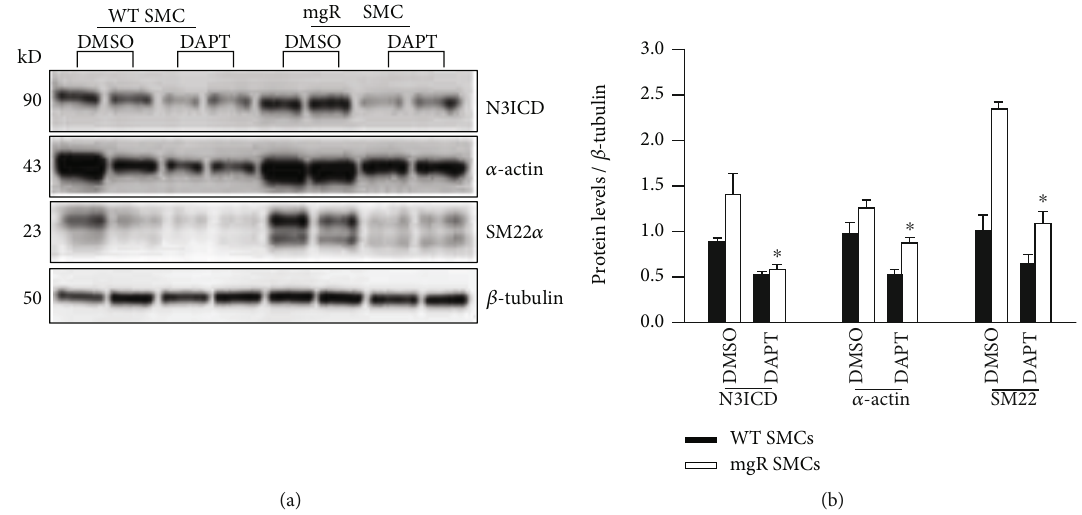
Figure 6: DAPT treatment inhibited Notch3 activation and reversed SMC phenotype of aortic SMCs from Fbn1 mgR/mgR (mgR) mice. Aortic SMCs were isolated from WT and mgR mice and treated with DMSO or DAPT (20 mM) for 48hrs. Protein from cells was extracted. (a) The levels of Notch3 activation (N3ICD), α -actin, and SM22 α were examined by Western blot analysis. (b) The bar graph shows relative N3ICD, α -actin, and SM22 α levels in the cells. ∗ P < 0 : 05 compared to DMSO-treated mgR